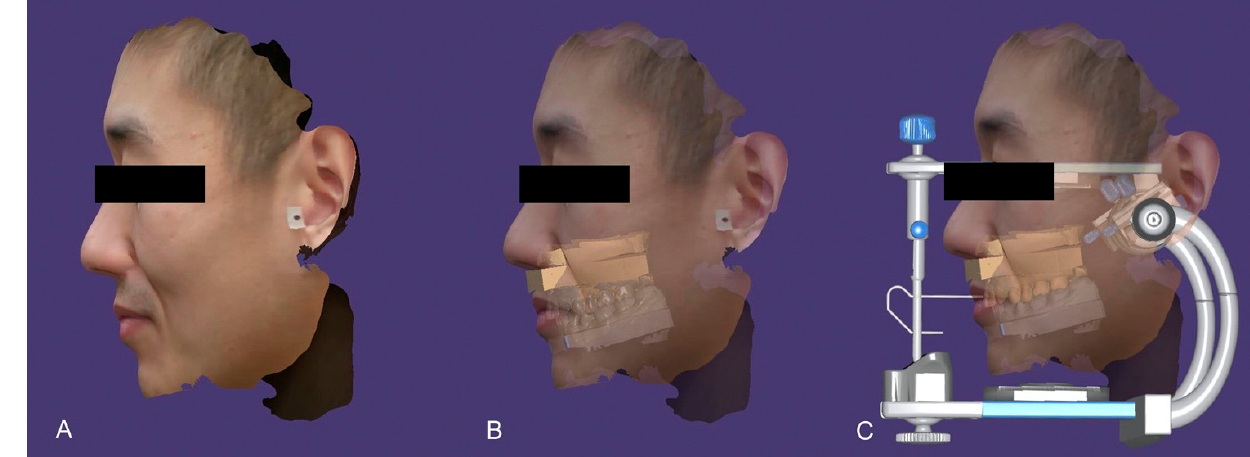
Figure 5. Virtual patient workflow. Facial scan captured ( A ), Facial scan merged with intraoral scan ( B ), Facial scan and intraoral scan mounted on a virtual articulator ( C ).